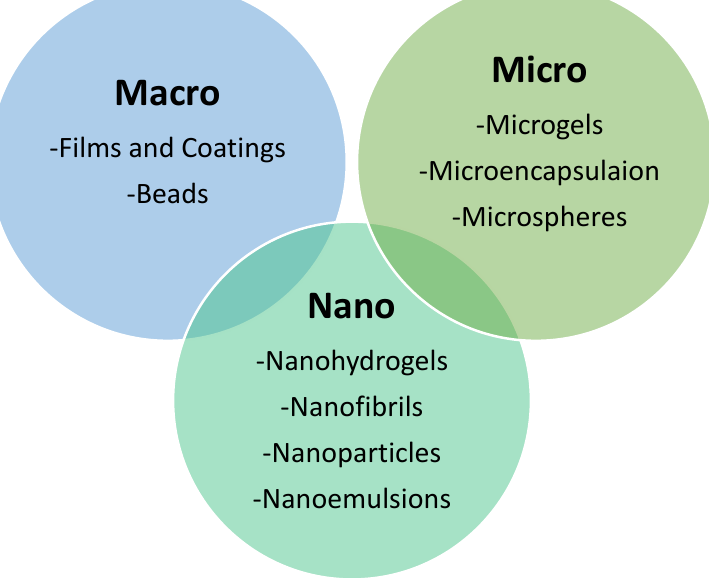
Figure 2. Whey protein systems used as delivery vehicles for bioactive ingredients in food.